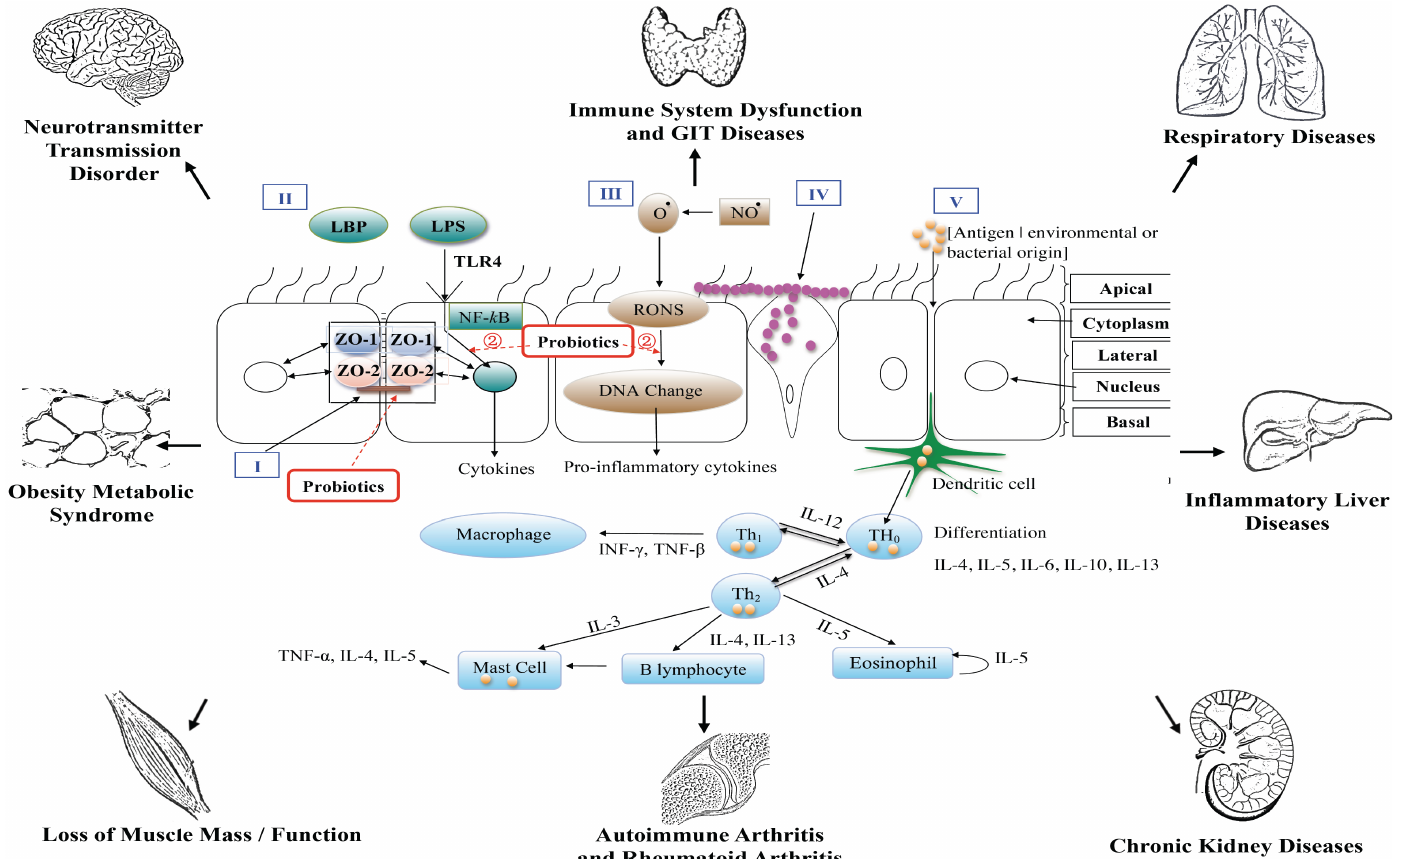
Figure 2. A diagrammatic representation of the epithelial barrier of the gastrointestinal tract and end–organ